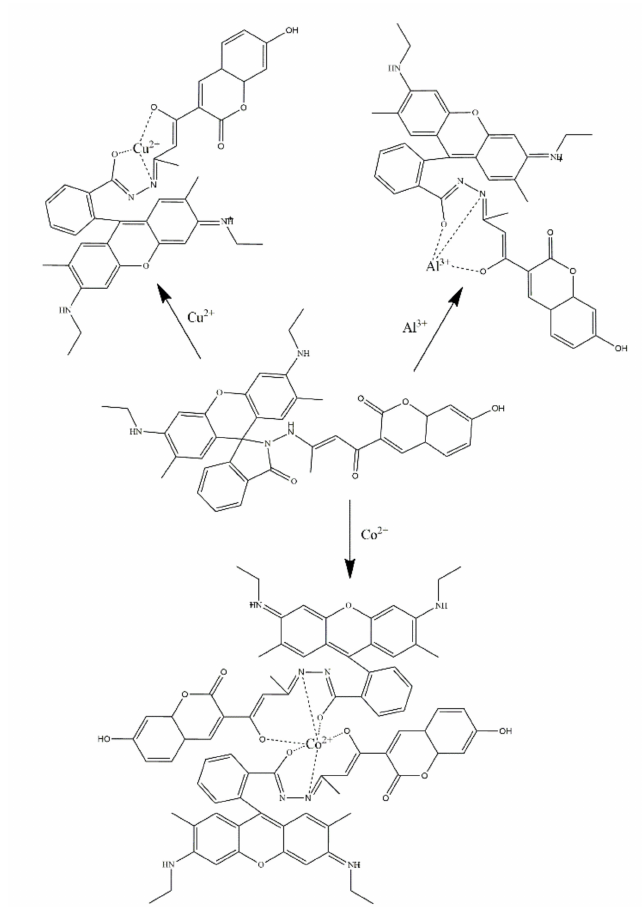
Figure 63. The proposed reaction mechanism of the prepared sensor (Table 4, No.17) with Cu 2+ , Co 2+ , and Al 3+ [122].